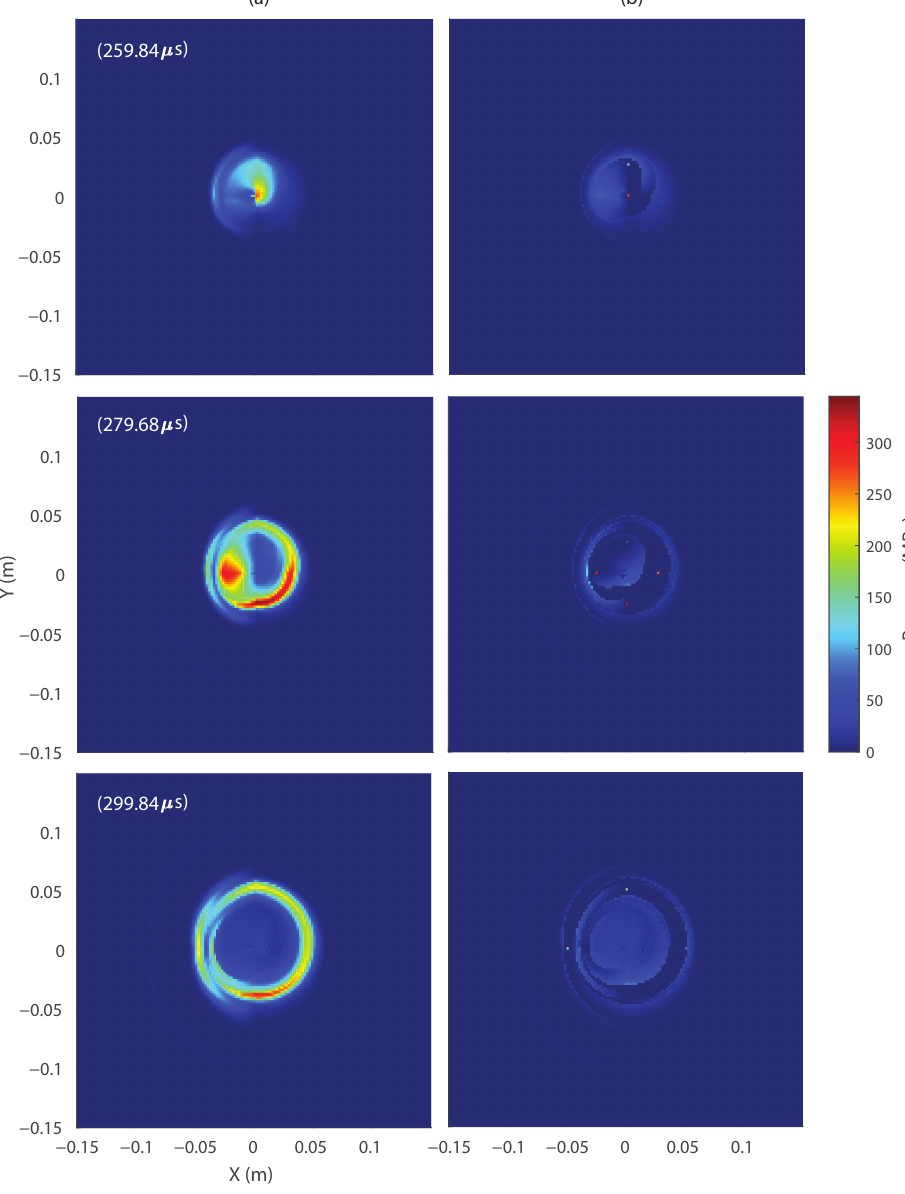
the D 50 = 0.8 mm (from Figure 1), average wave speed at 50 mm radius was 769.8 m/s, and the maximum recorded pressure was 195.2